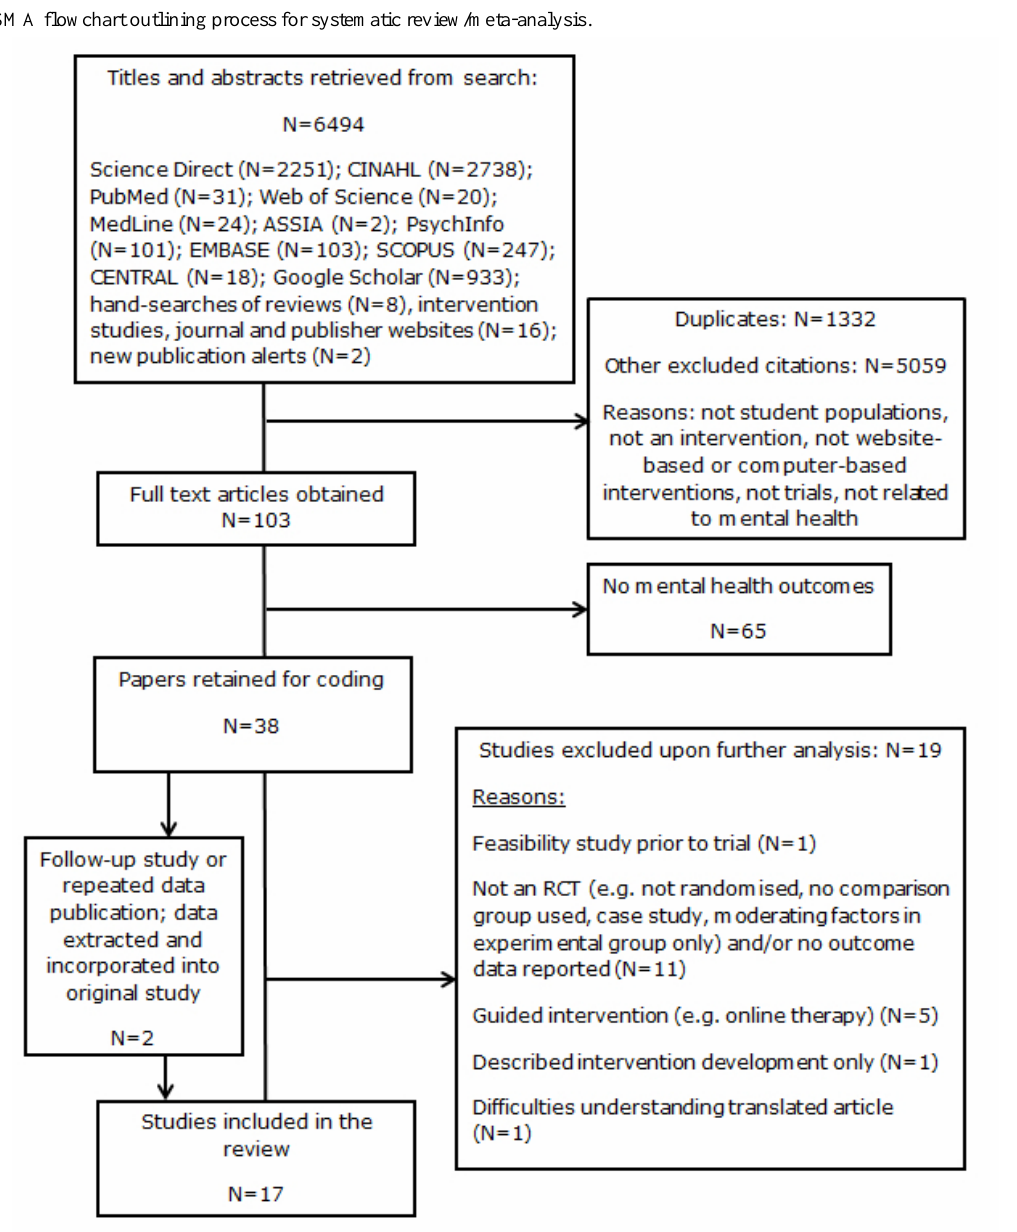
Figure 1. PRISMA flowchart outlining process for systematic